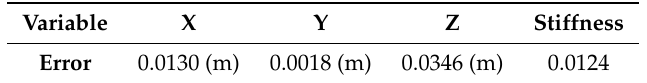
Table 1. Average error of robot